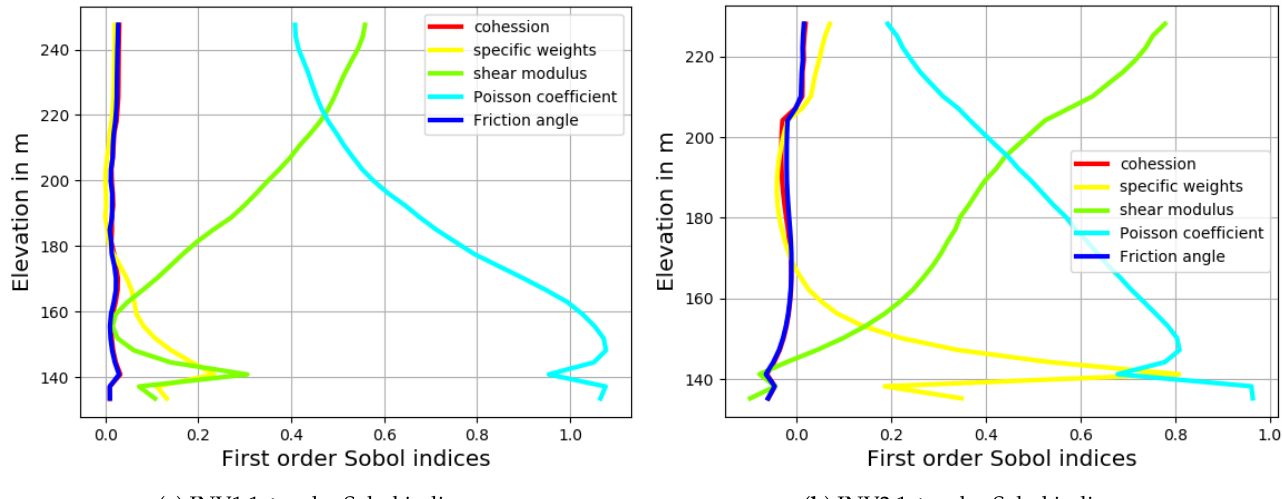
( a ) INV1 1st-order Sobol indices. Figure 15. First Sobol index results obtained using ensemble